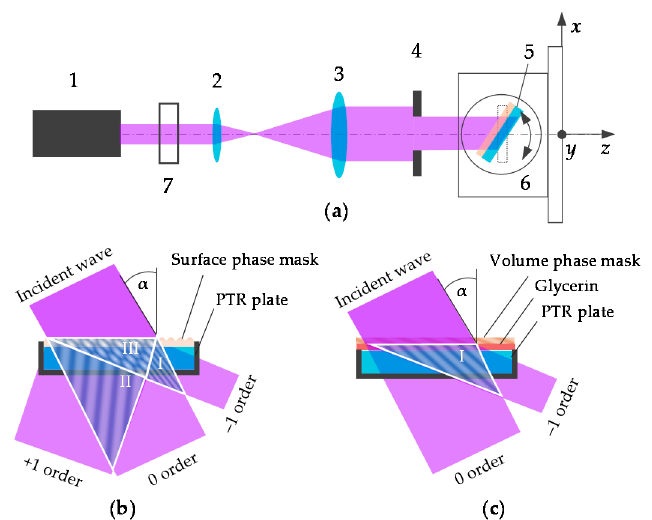
( a ) Scheme of the recording set up: 1—He-Cd laser, 2, 3—lenses, 4—diaphragm, 5—mask / waveguide sandwich in conical exposition, 6—angular positioner, 7—shutter. Near-field area formed by single exposure of ( b ) surface phase mask and ( c ) Bragg phase